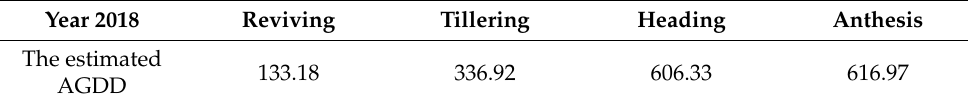
Table 3. The estimated accumulated growing degree days in 2018.